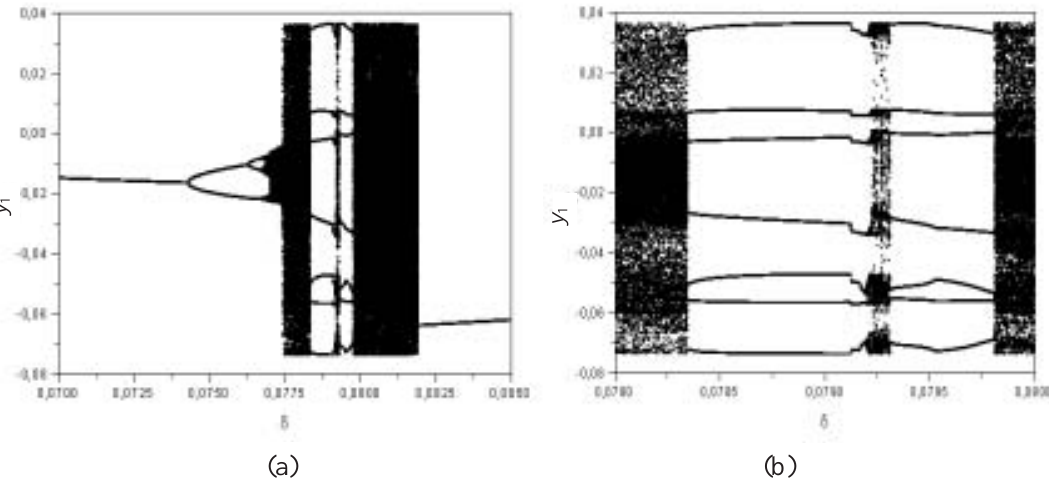
Fig. 11. Bifurcation diagram varying force amplitude parameter δ with θ = 1 . 5 : (a) 0 . 07 (cid:1) δ (cid:1) 0 . 0850 . (b) 0 . 078 (cid:1) δ (cid:1) 0 . 08